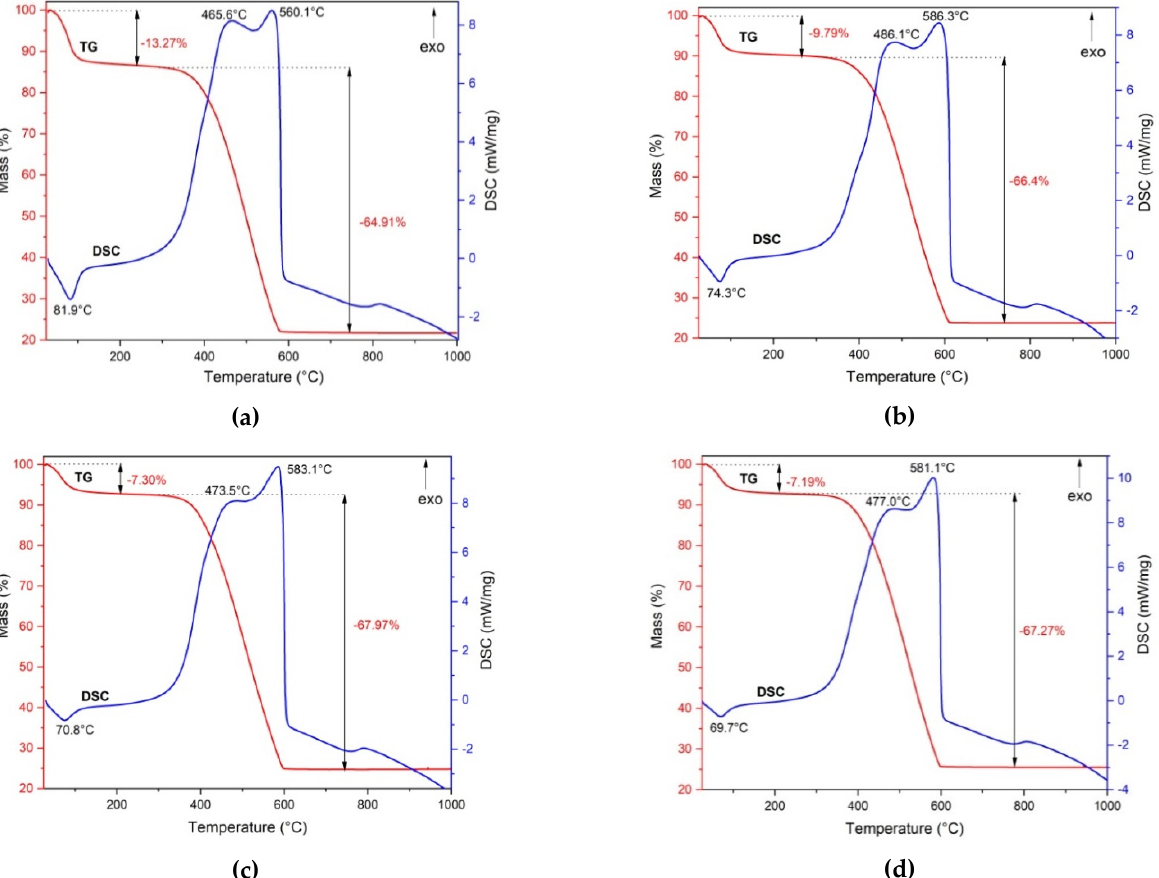
Figure 6. The TG and DSC curves of magnetic nanocomposites: PM1 ( a ), PM2 ( b ), PM3 ( c ), PM4 ( d ). The four samples presented similar behaviors when heated to 1000 °C. The TG curve indicates that all samples exhibited a two-step mass loss. In the first stage, up to 100 °C, the samples underwent a mass loss due to the water removal. This process was accompa- nied by an endothermic effect, as indicated by the DSC curves. In the first stage, PM1